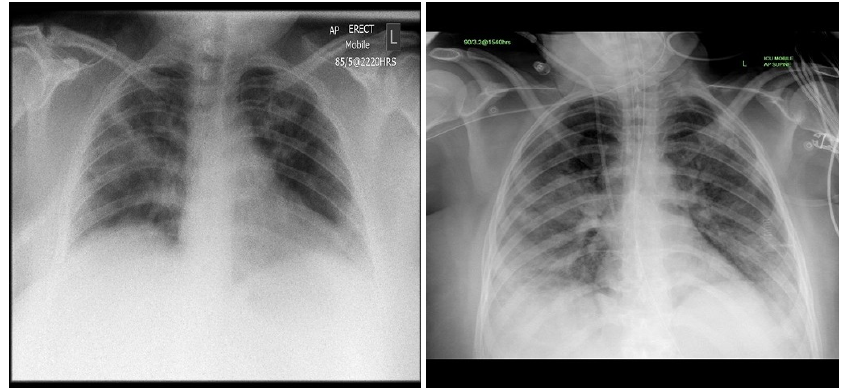
Figure 5. Examples of COVID-19 image data collection (CIDC) images